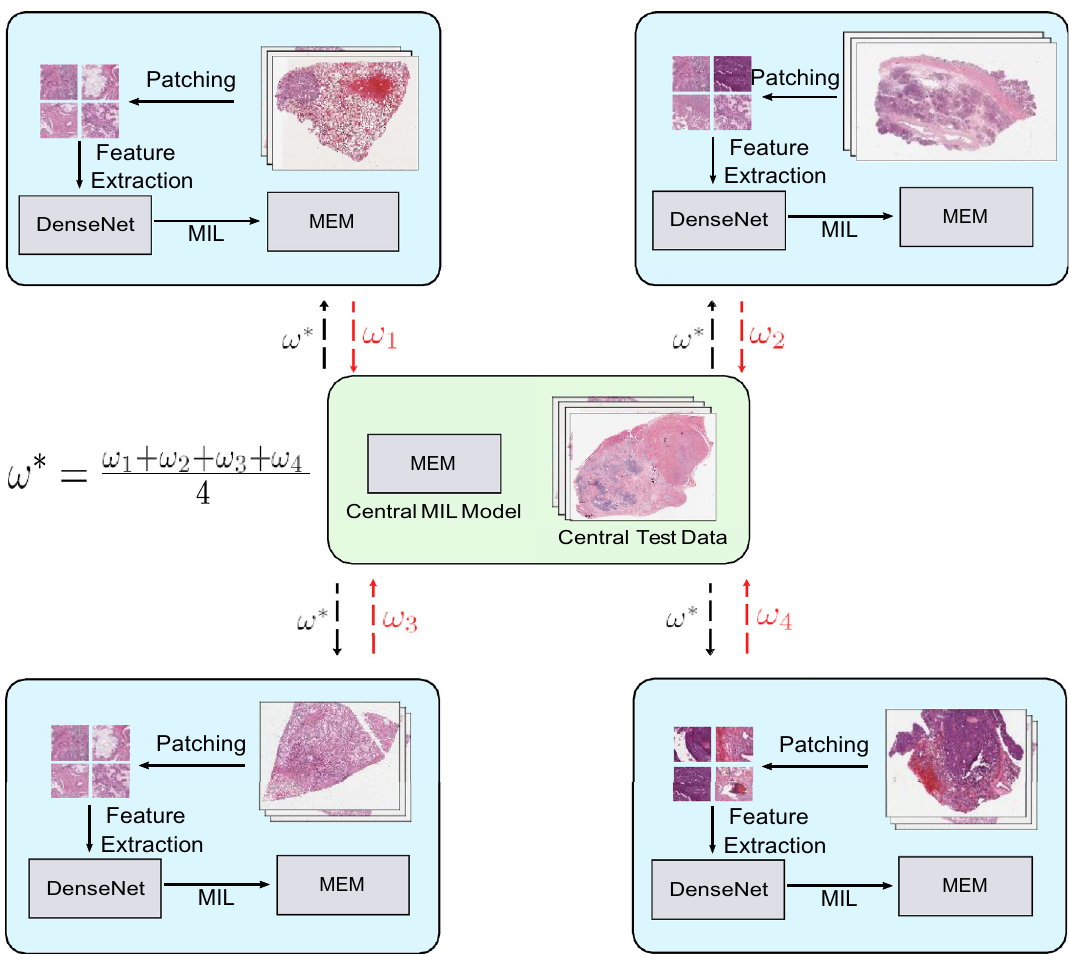
Figure 1. The proposed federated learning algorithm to train a MEM model 33 for WSIs (disease) classification among multiple hospitals. Each client in FL is represented by a blue rectangle. Each client, first transforms their local WSIs into mosaics (sets of representative patches). The patches in each mosaic are converted to feature vectors using a DenseNet model 34 . Finally the sets of feature vectors are classified using a MEM model. A shared central MEM model is trained using FedAvg 6 among multiple clients (mimicking hospitals). Furthermore, DP-SGD 22 is used for training the central MEM model with strict privacy bounds.